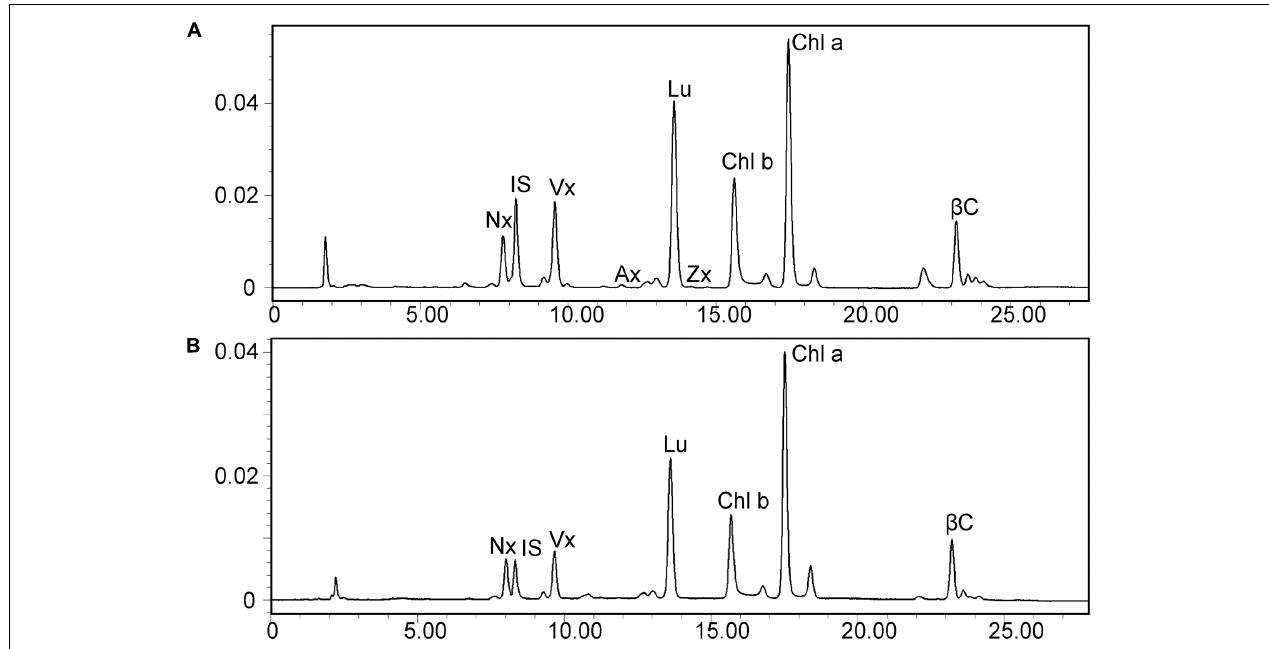
FIGURE 3 | High-performance liquid chromatography (HPLC) separation of pigments in 3-week-old rosette leaves of the dy1 mutant (A) and the wild-type (B) plants. Peaks are neoxanthin (Nx), internal standard (IS), violaxanthin (Vx), antheraxanthin (Ax), lutein (Lu), zeaxanthin (Zx), β -carotene ( β C), and chlorophyll a and b (Chl a and Chl b